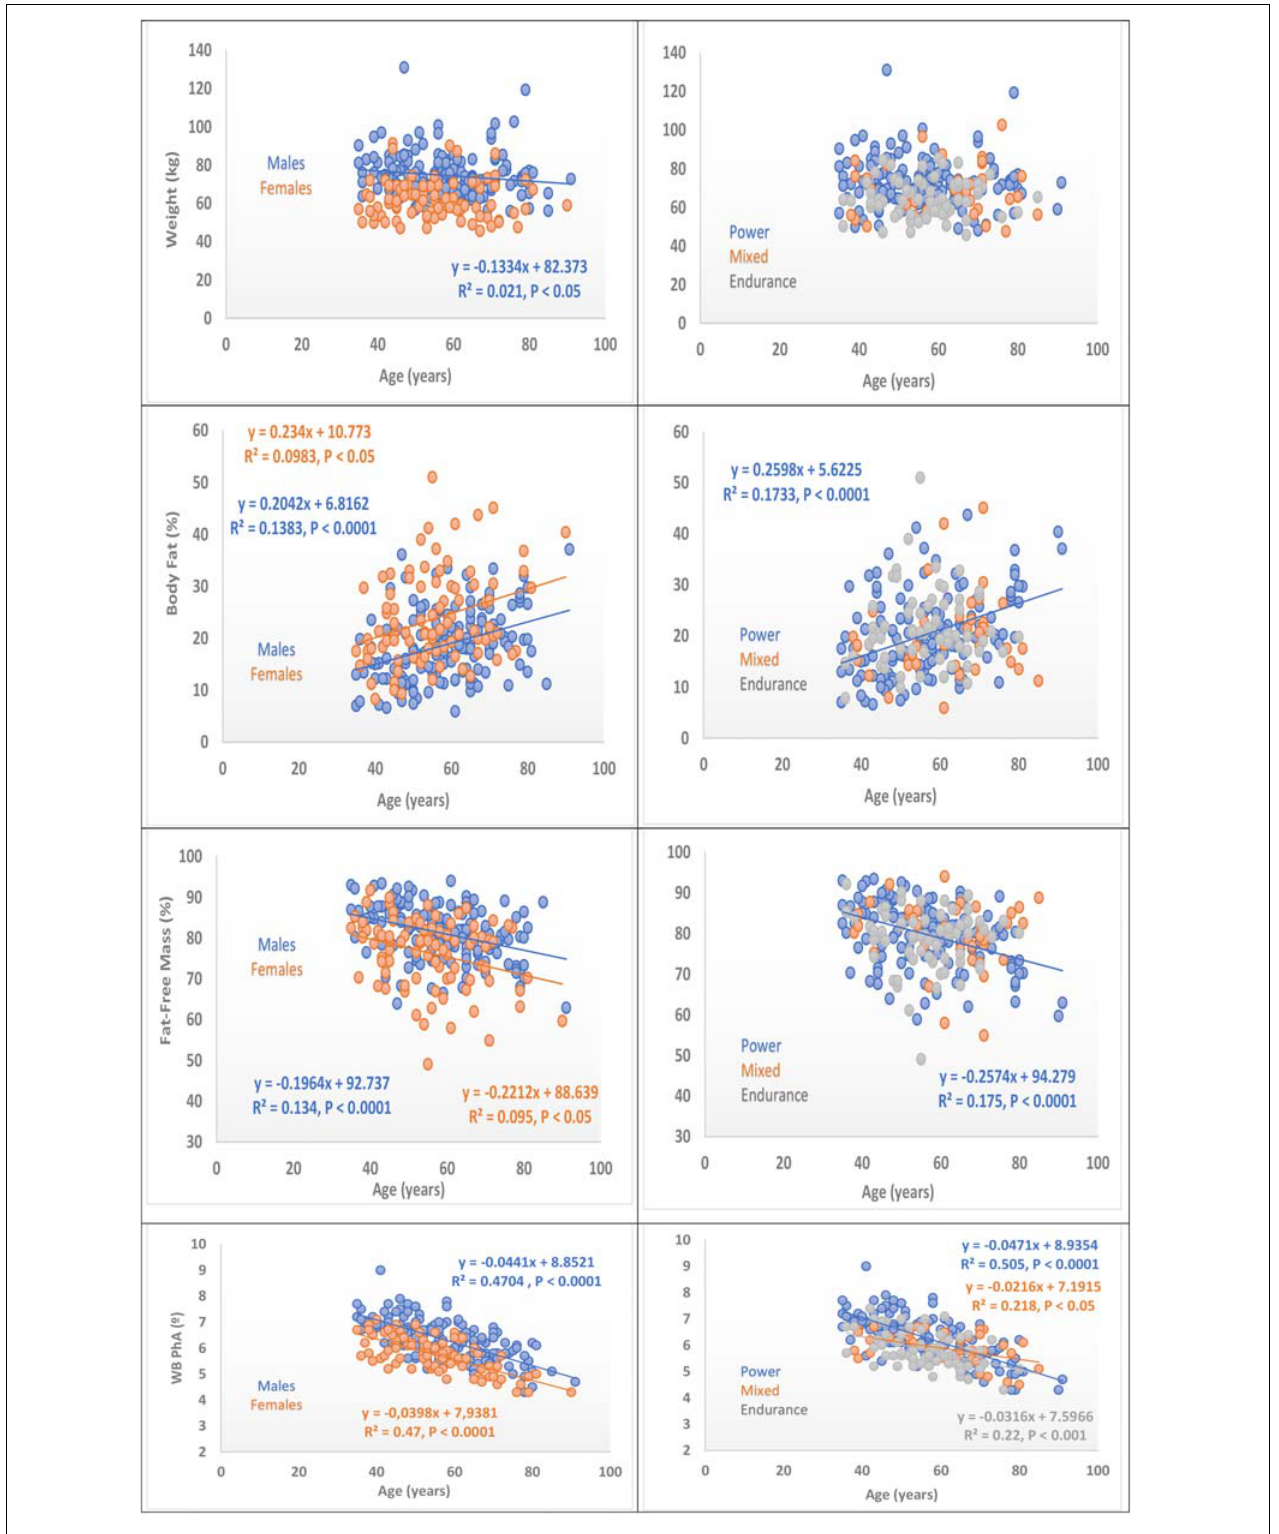
FIGURE 2 | Age dependency of body composition variables of Master Athletes. At left: Comparison of variables by gender. At right: Comparisons of variables by sport specialty, WB PhA, whole body phase angle, regression lines, and equations are represented and consigned when they are significant (see correlation coefficients in Tables 4A,B